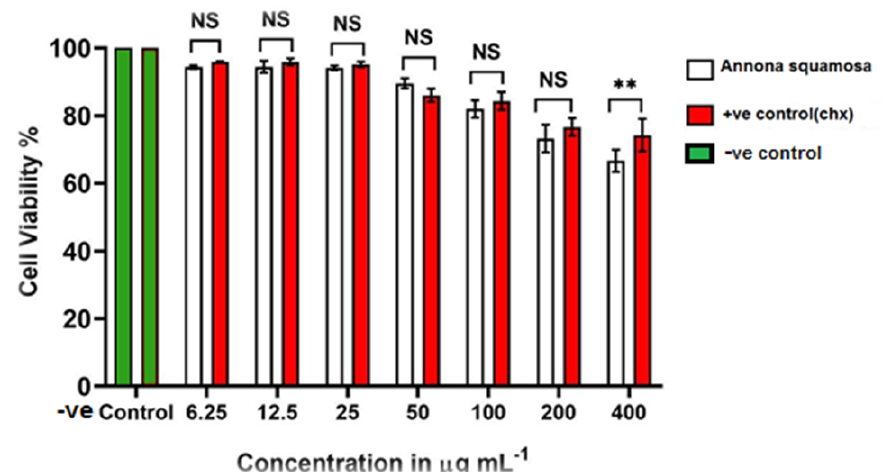
Figure 2: Graph showing the means of cells viability (%) of Annona squamosa and the positive control Chlorhexidine 0.12% and negative control at different